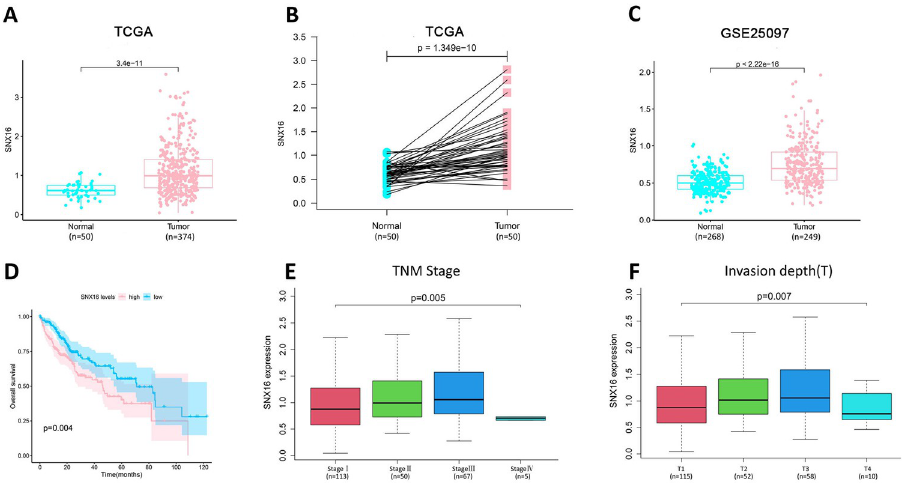
Fig 2. The pro-carcinogenic role of SNX16 in HCC. (A) Differential expression of SNX16 in HCC based on TCGA data. (B) Differential expression of SNX16 in paraneoplastic and HCC tissues based on TCGA data. (C) Differential expression of SNX16 in dataset GSE25097. (D) Analysis of overall survival of SNX16 in HCC patients. (E) Correlation of SNX16 expression with TNM stage. (F) Correlation of SNX16 expression with invasion depth.